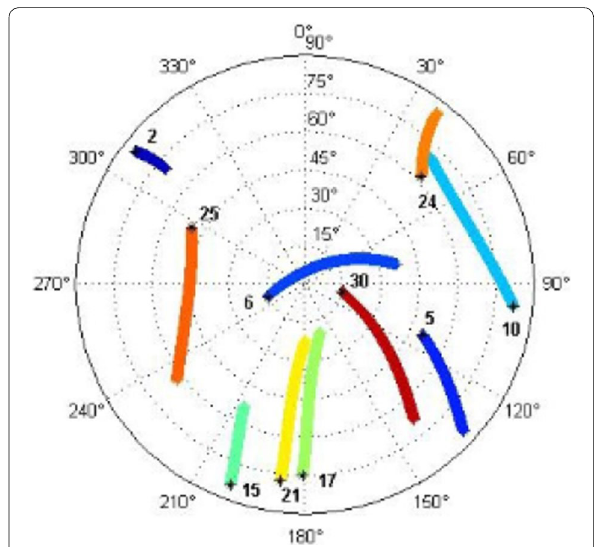
Fig. 7 Skyplot corresponding to the Seewinkel network. PRN6 is taken as the reference satellite for the computation of the